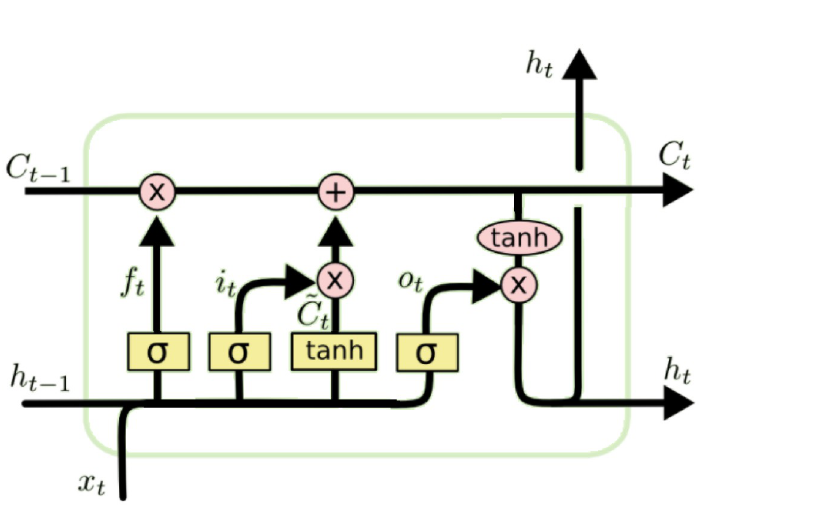
Fig 1. The LSTM model